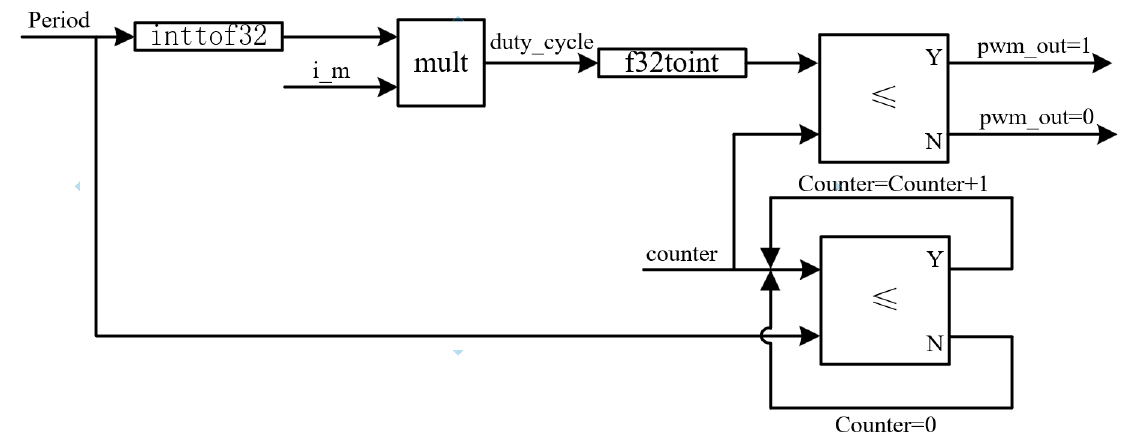
Figure 17. FPGA implementation diagram of PWM generator. (4) ADC